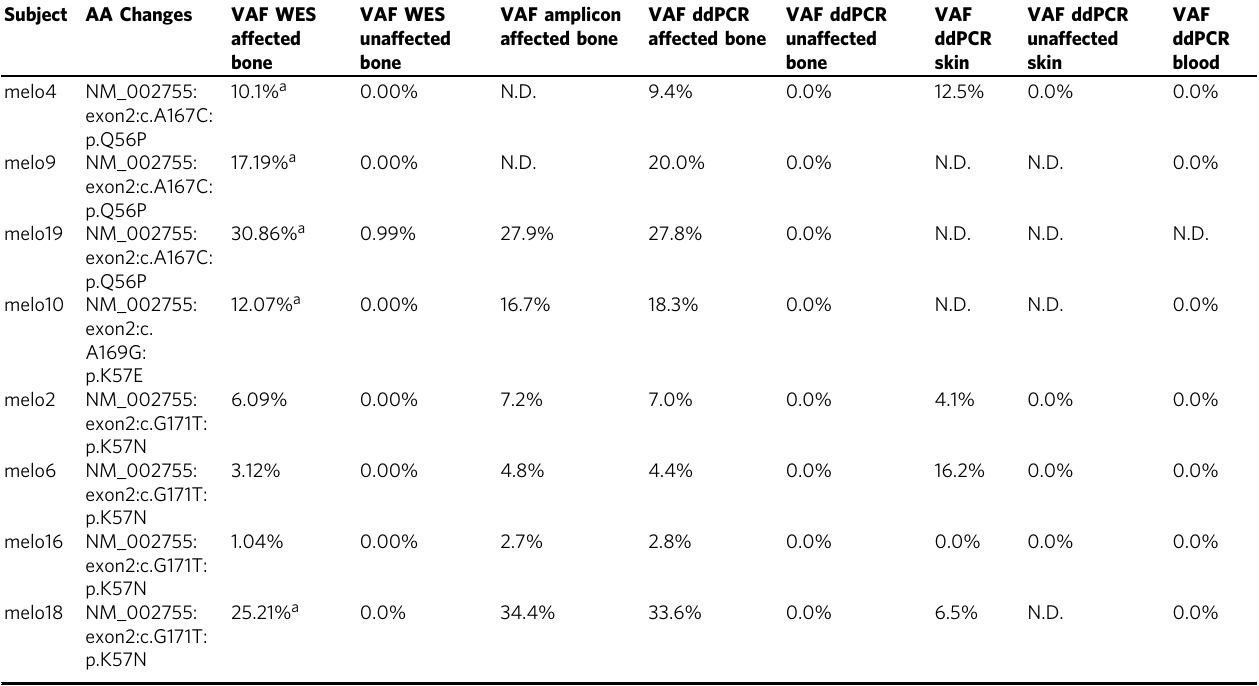
Table 1 Table of individual patients showing the mutation location, cDNA and protein consequences, and variant allele frequencies